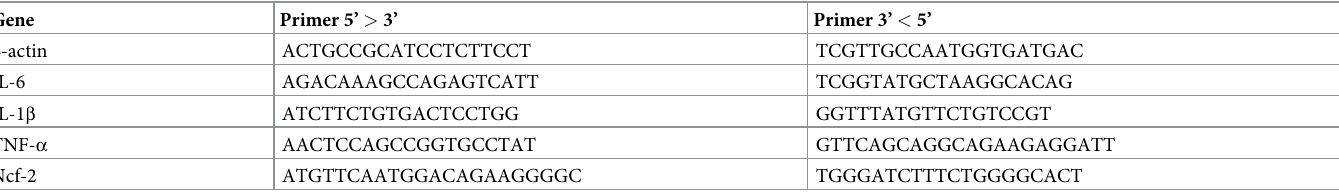
Table 1. Primers used for qPCR